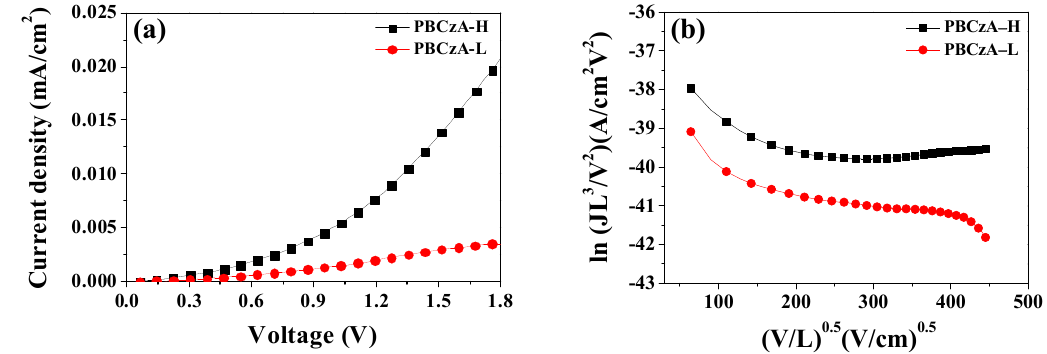
Figure 5. J–V characteristics of the hole-only devices measured in the dark ( a ) and ln (JL 3 / V 2 ) versus (V / L) 0.5 curves ( b ) based on the space-charge-limited current (SCLC) equation.